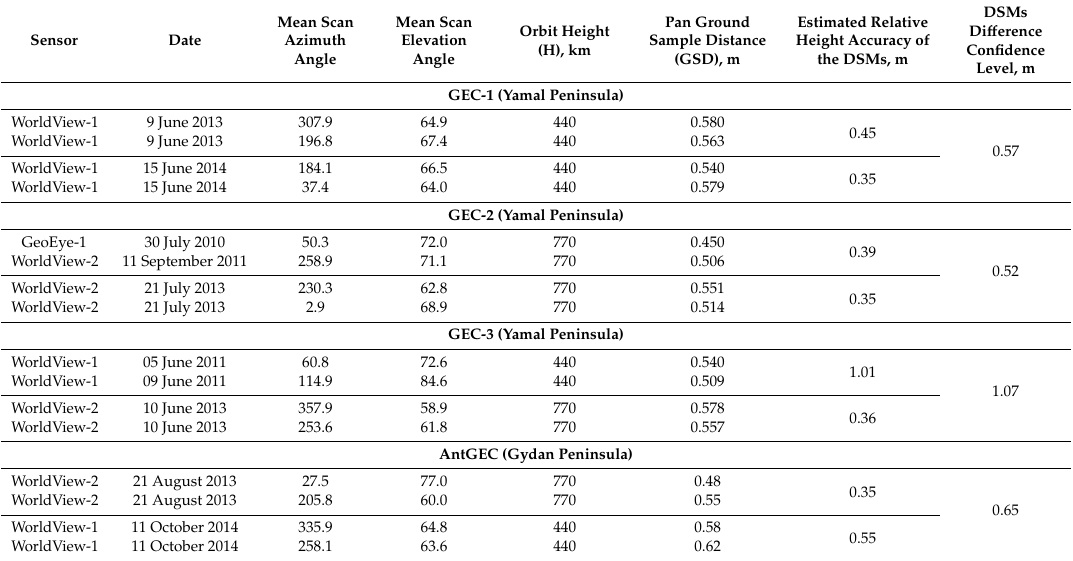
Table 2. Satellite imagery used for digital surface model (DSM)